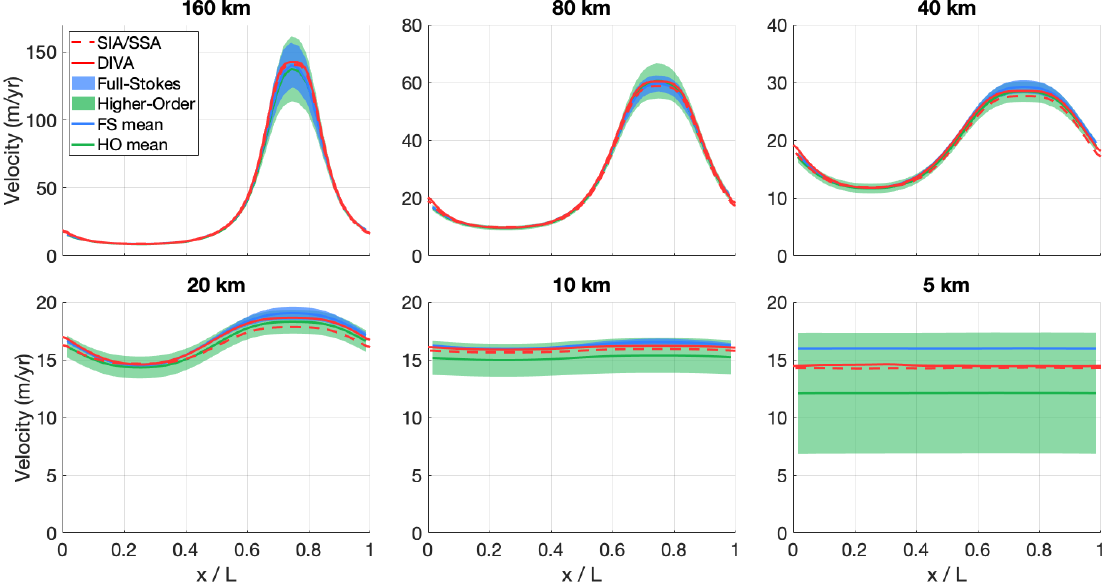
Figure B3. Modelled surface velocity transects for all versions of ISMIP-HOM experiment C (infinite ice slab on a sloping bed with oscillating friction in both directions), calculated with both the old hybrid SIA/SSA solver (dashed red line) and the new DIVA solver (solid red line). The results of the higher-order models (green) and the full-Stokes models (blue) that participated in ISMIP-HOM are shown for comparison.